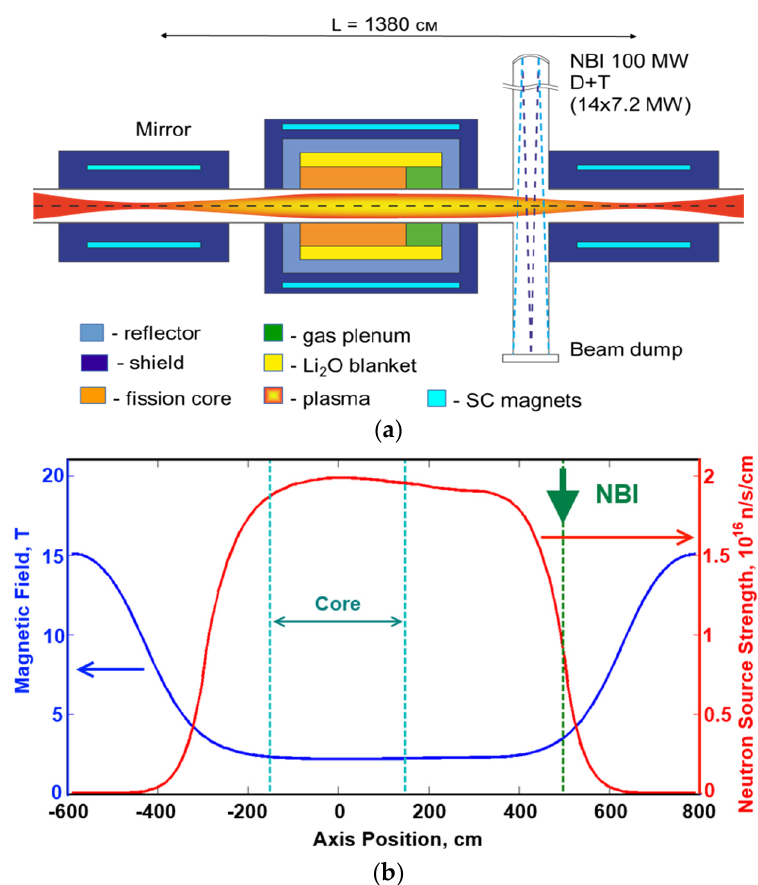
Figure 6. ( a ) Schematic view of FDS with mirror NS; ( b ) Magnetic field strength ( left scale ) and neutron emission yield ( right scale ) along the NS axis. Vertical dashed lines indicate the sub ‐ critical core and the neutral beam injector